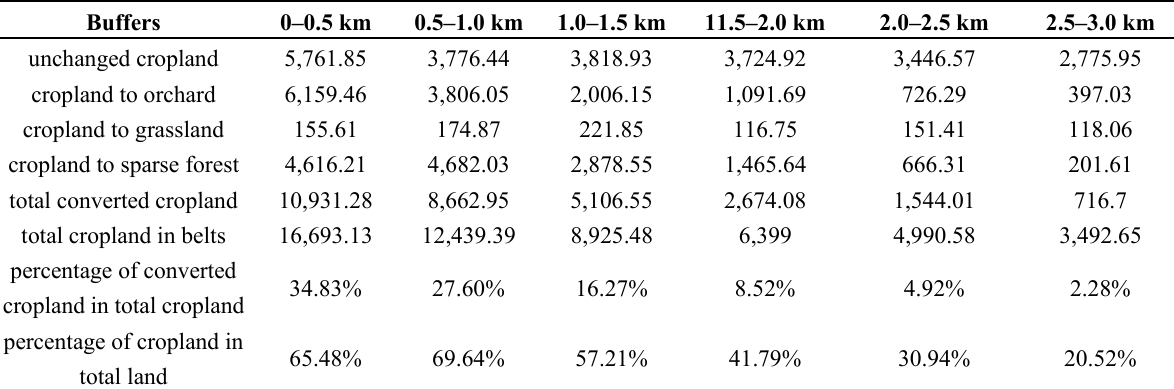
Table 7. The area of converted cropland in each belt referring to the main